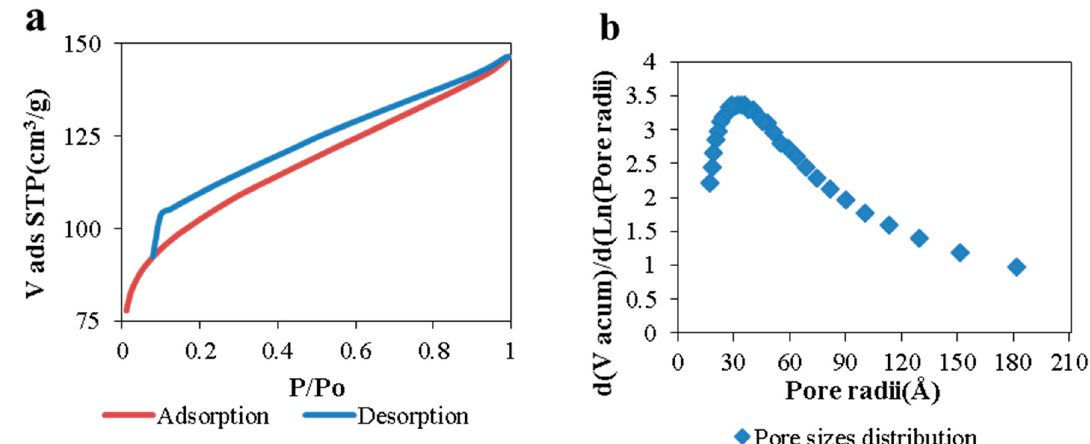
Figure 3. N 2 adsorption ‐ desorption isotherms at 77 K ( a ) and pore size distribution ( b ) for CAG 90.